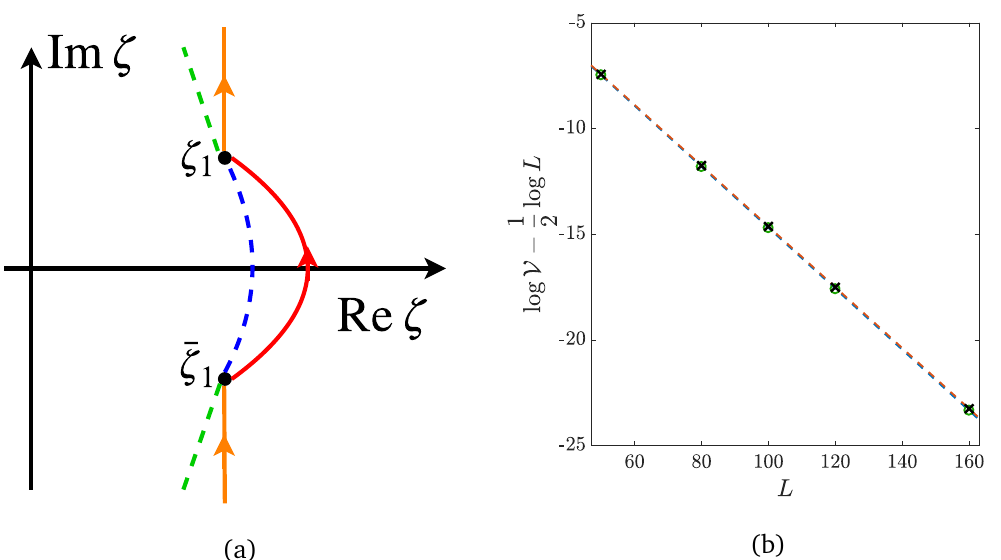
Figure 14: (a) Integration contours for computing the overlap coefficient between a one-cut state and the vacuum descendant. Square-root branch cut of p ( ζ ) is indicated by blue dashed line, whereas all the additional branch cuts due to the dilogarithm function are marked by green dashed line. The integration contour, marked in red (orange) on the upper (bottom) Riemann sheets, escape to infinity on the bottom sheet. (b) Logarithm of the overlap coefficient between the one-cut solution with n = 1 and ν = 0.1 and a vacuum descendant state. Green circles (black crosses) show numerical data for interaction parameter δ = 0 ( δ = 1), respectively, with dashed lines corresponding to linear